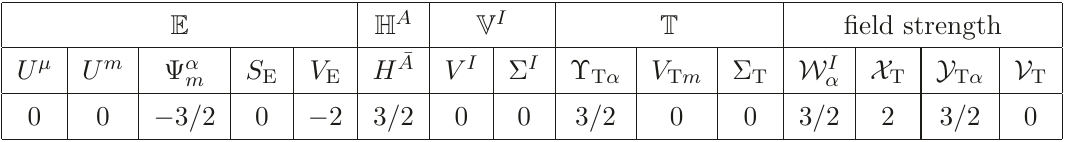
Table 1 . The Weyl weights of the Tensor multiplet